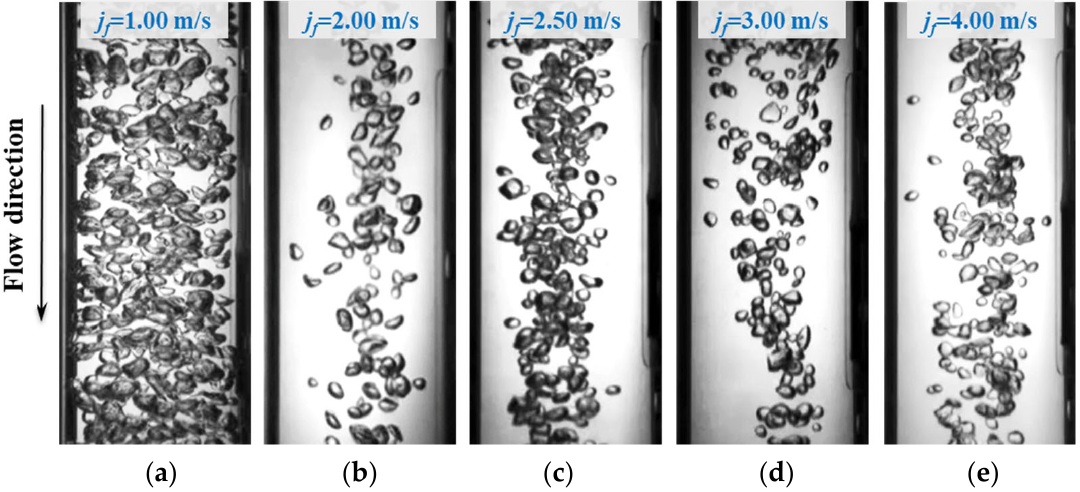
Figure 8. Comparison of bubble distribution for and j g,loc = 0.08 m/s and increasing j f in VD bubbly flows. ( a ) Re f = 5 × 10 4 ( b ) Re f = 10 5 ( c ) Re f = 1.25 × 10 5 ( d ) Re f = 1.5 × 10 5 ( e ) Re f = 2 × 10 5 .